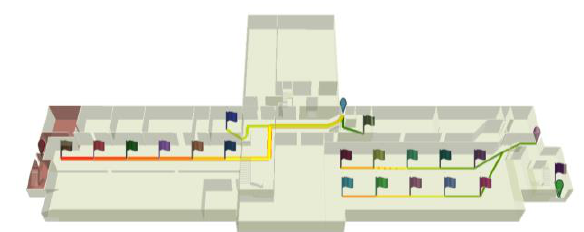
Figure 21. Generated Evacuation Basement Floor Routes for